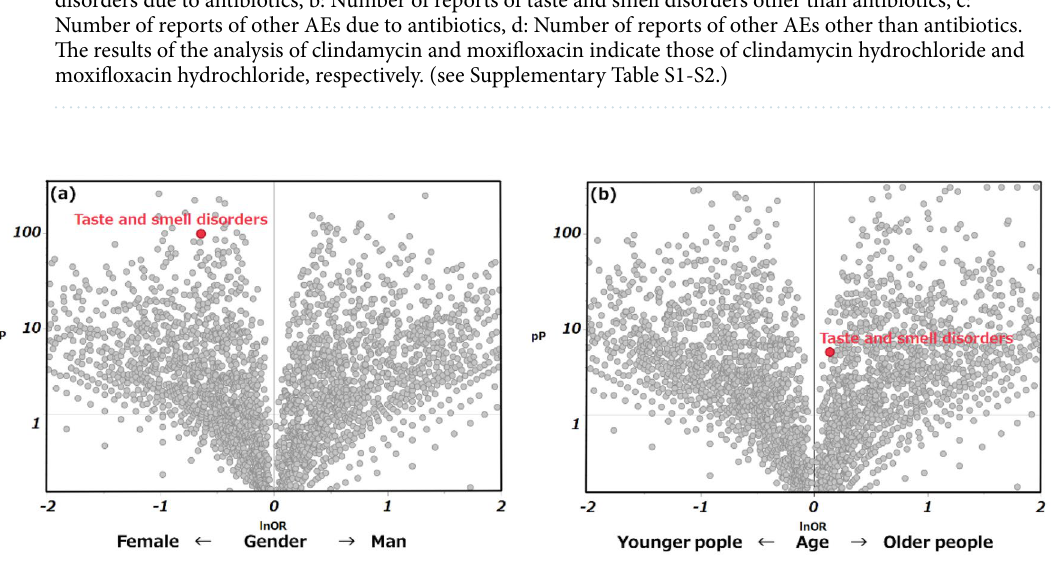
Figure 2. Relationship between antibiotic-induced taste and smell disorders and gender/age. Volcano plots of taste and smell disorders and gender differences/age due to antibiotics. ( a ) It was suggested that this was more likely to occur in women than in men. ( b ) Older people are defined as being over 60 years old. It was suggested that it is more likely to occur in older people over 60 years old than in younger people.